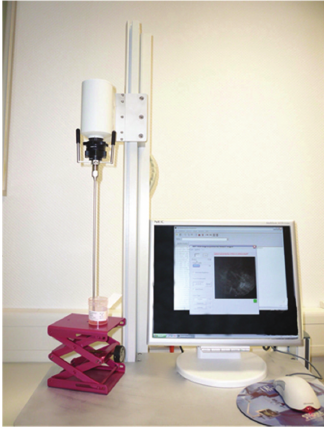
Figure 1: Confocal endomicroscope